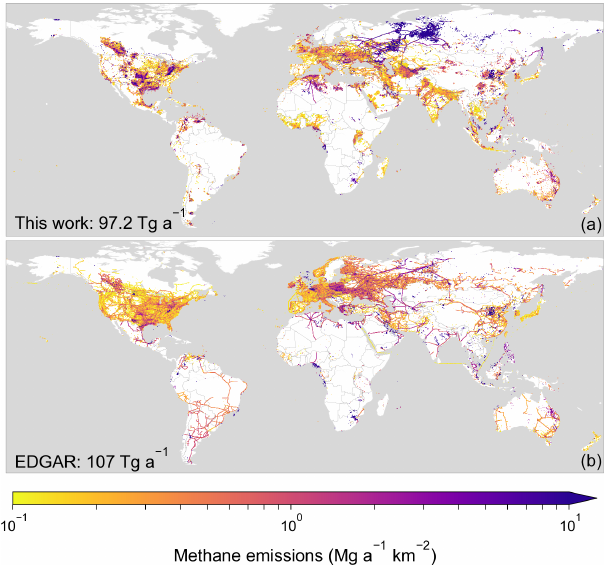
Figure 5. Total methane emissions from fuel exploitation (sum of oil, gas, and coal) in 2016 from this work (a) and in 2012 from EDGAR v4.3.2 ( b ; European Commission, 2017). Emissions below 10 − 1 Mga − 1 km − 2 are not